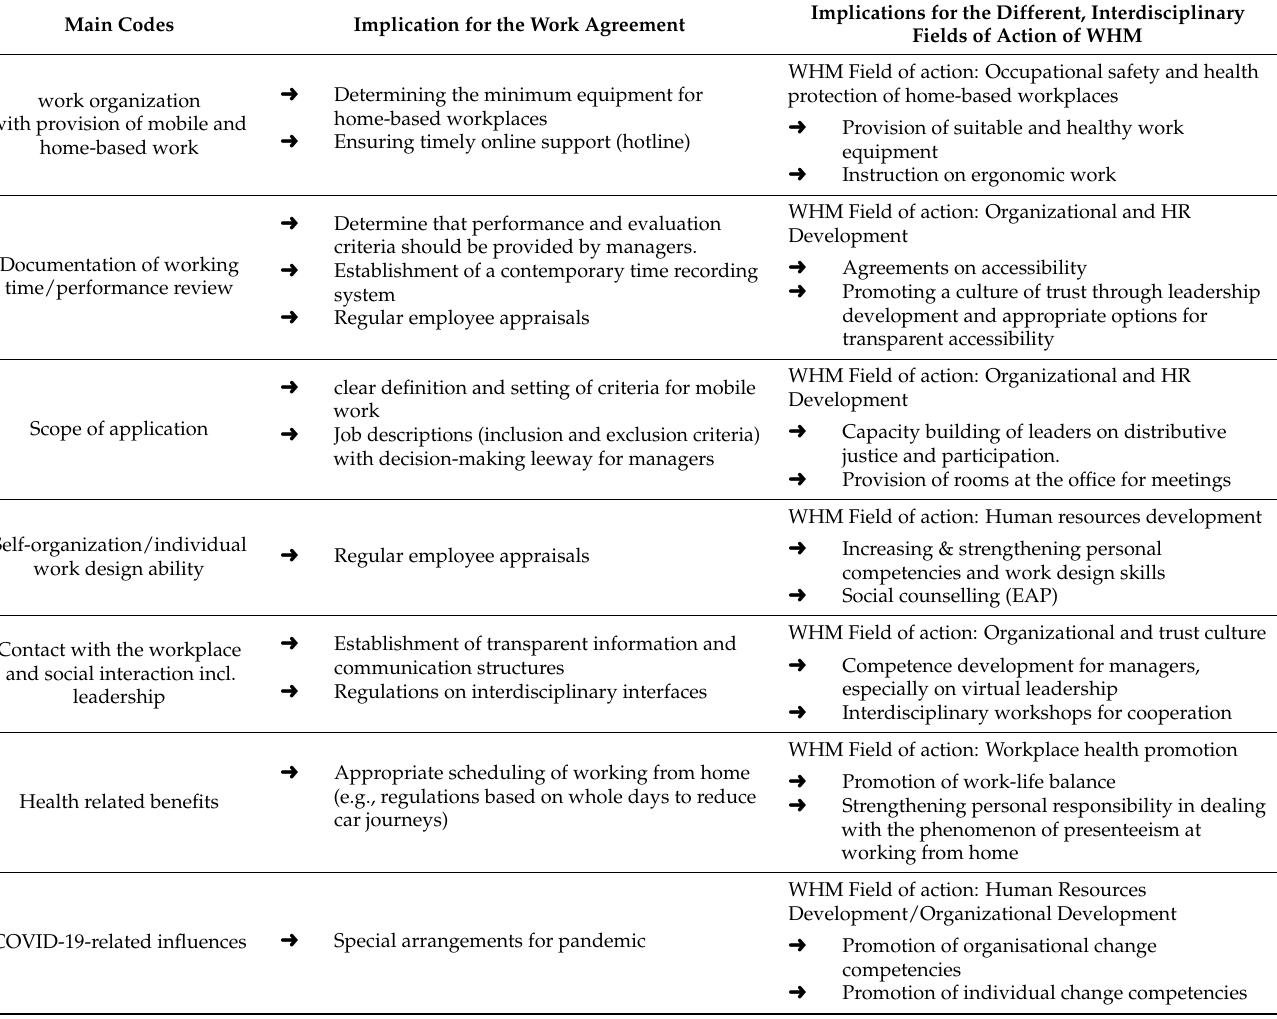
Table 2. Implications for work agreement and WHM based on the qualitative study